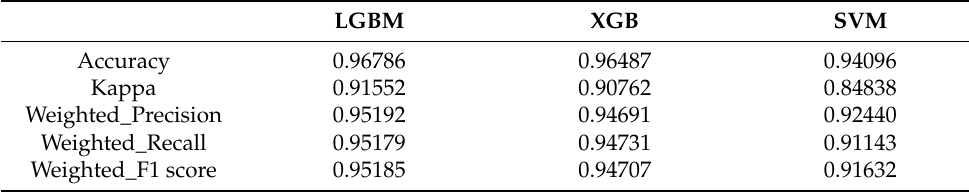
Table 1. Comparison of the performances of the three